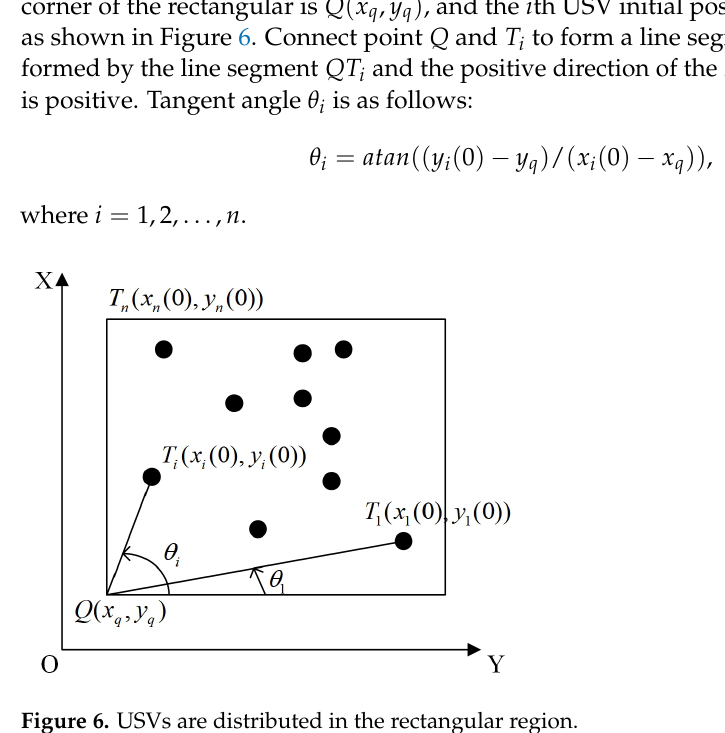
Figure 6. USVs are distributed in the rectangular region. The design process of this method is as